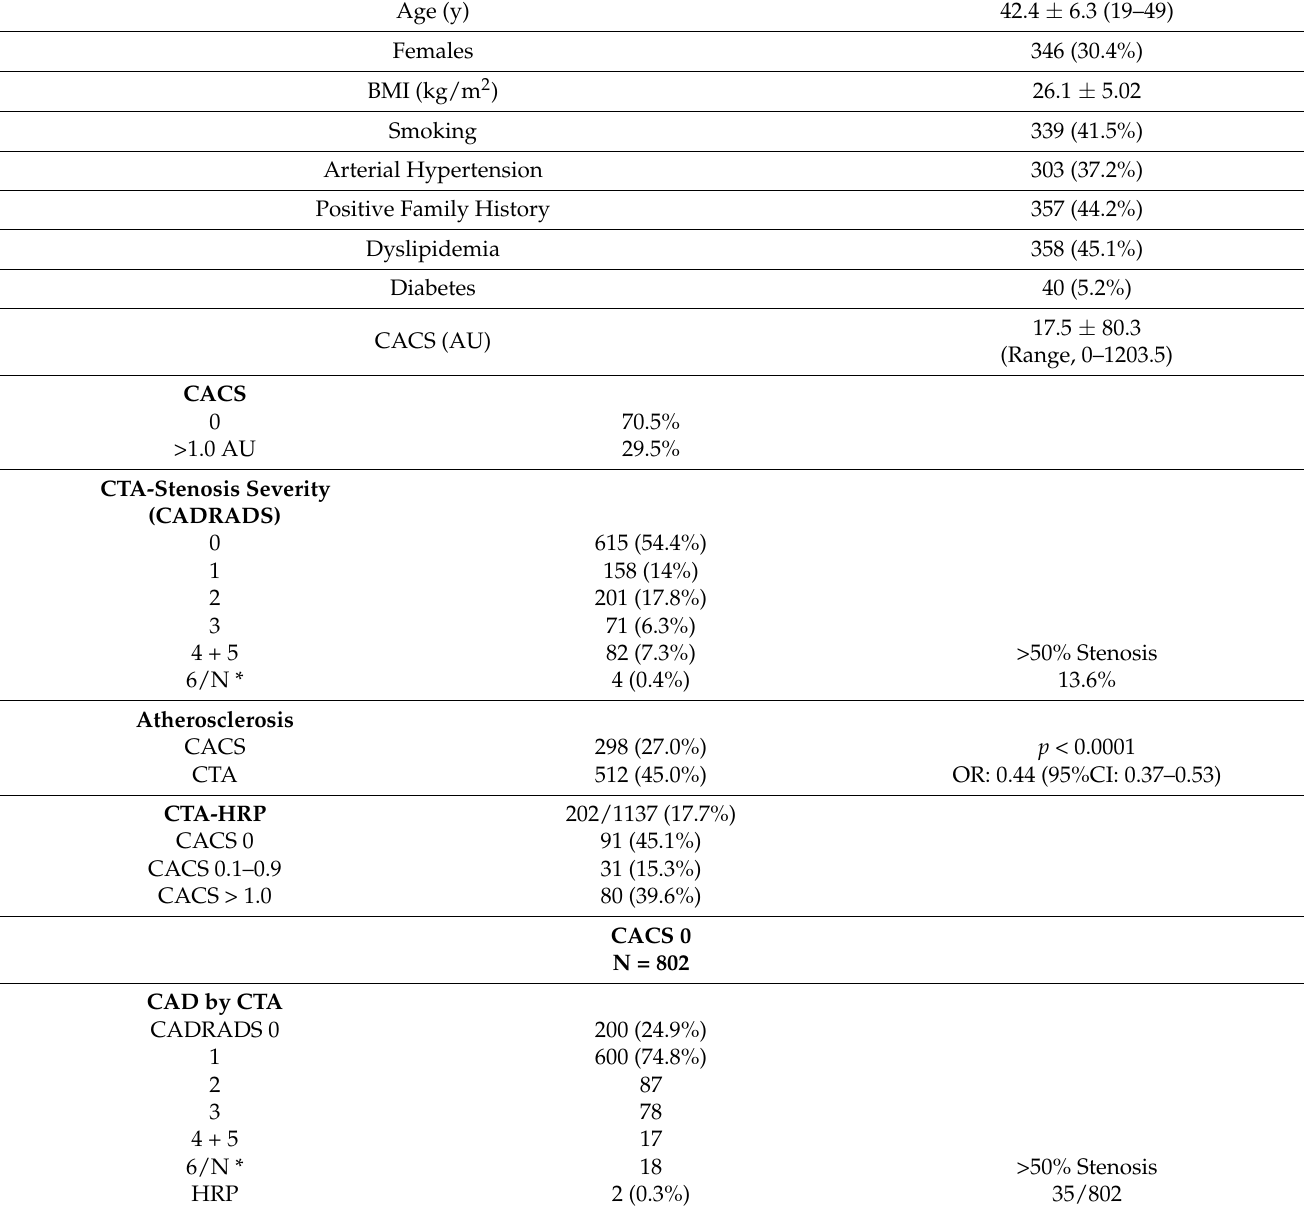
Table 1. Study population, coronary artery calcium score (CACS) and coronary CTA